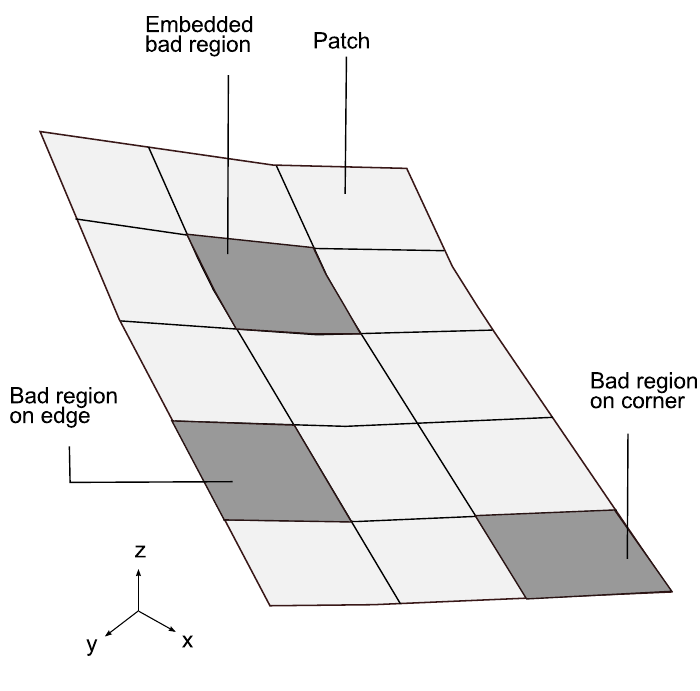
Figure 3. Possible locations for bad regions in a